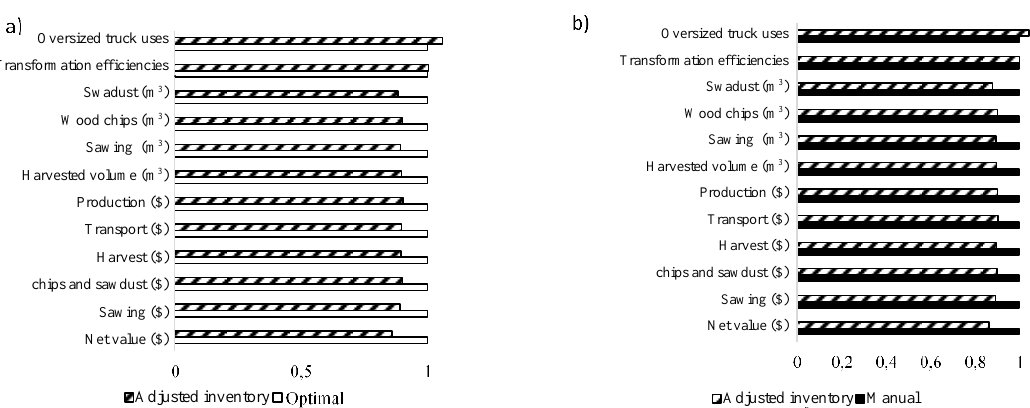
Figure 8. Impact of changing inventory data on the optimal ( a ) and manual ( b )